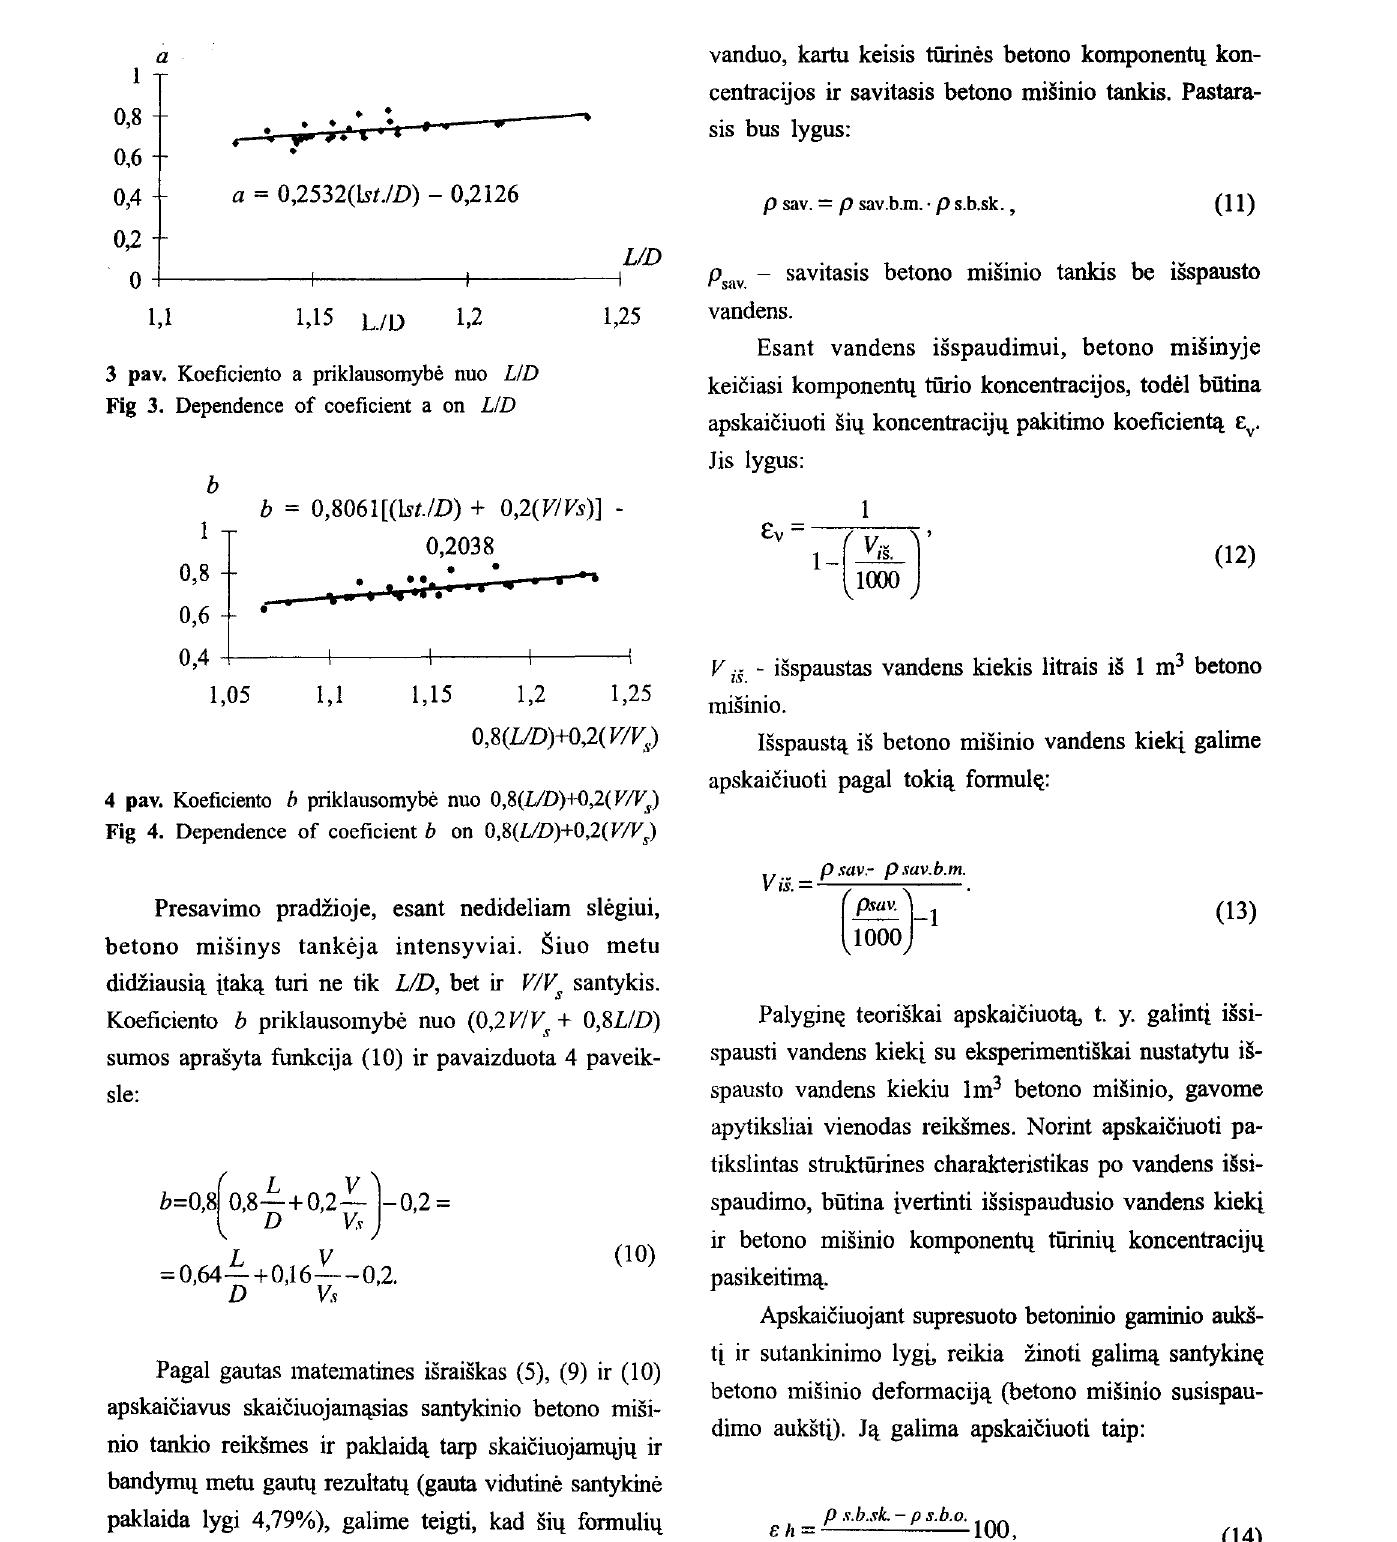
Presavimo pradzioje, esant nedideliam slegiui, betono misinys tankeja intensyviai. Siuo metu didiiausill_ itakll_ turi ne tik LID, bet ir V/Vs